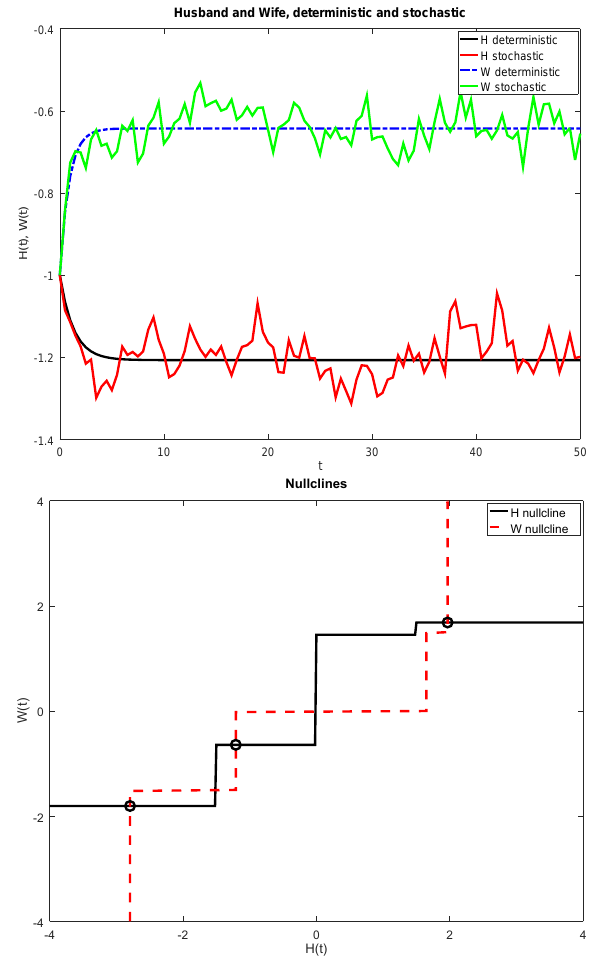
Figure 2. Piece-wise constant influence functions, scenario 1. Plot of H and W vs. time for the deterministic case and a stochastic realization ( top ) and a plot of the nullclines and the equilibrium points ( bottom ). Observe that these nullclines are discontinuous; therefore, for the H nullcline only, the horizontal lines count, and, for the W nullcline, only the vertical parts count.